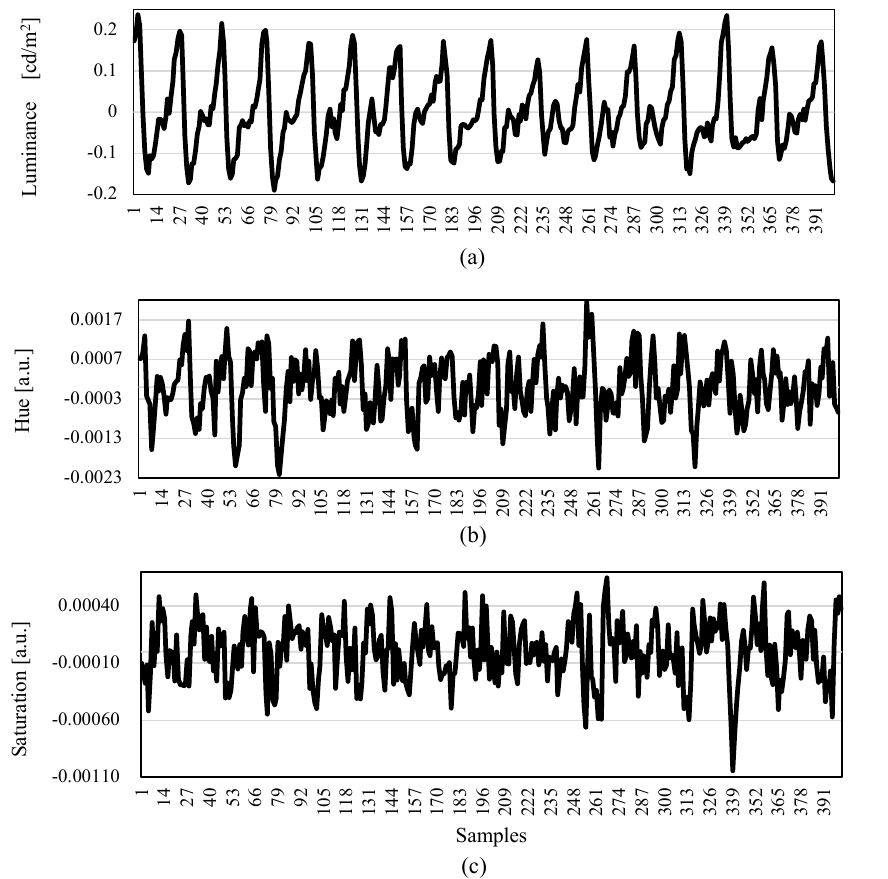
Figure 7. Pulse wave measurement based on changes in ( a ) luminance, ( b ) hue, and ( c ) saturation. The measurement was conducted on the palm of a healthy person’s hand. The horizontal axis shows the data sample index with time resolution of 25ms (the sampling frequency of 40Hz). It was confirmed that the best way to measure the AVF pulse wave was achieved based on the change with the